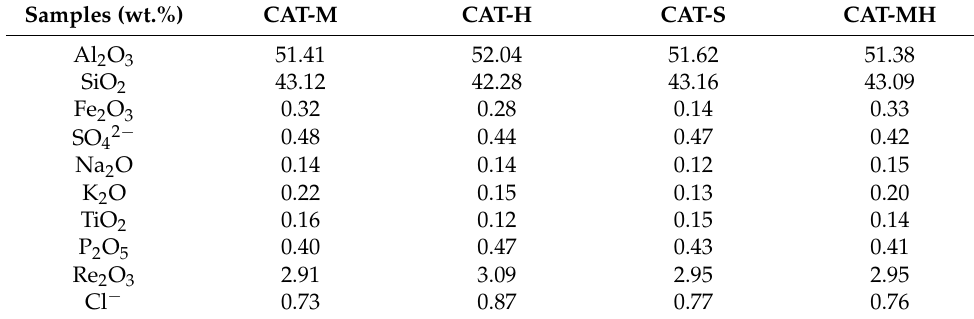
Table 3. Chemical compositions of the catalysts.